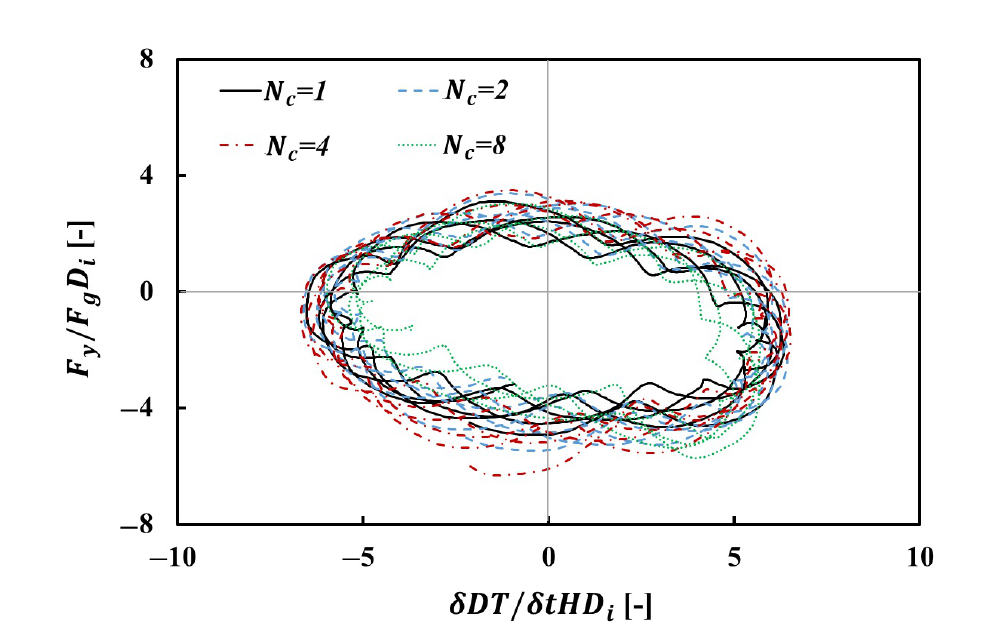
Figure 17. Normalised force–velocity diagram for the last five oscillation cycles with D i = 0.25.